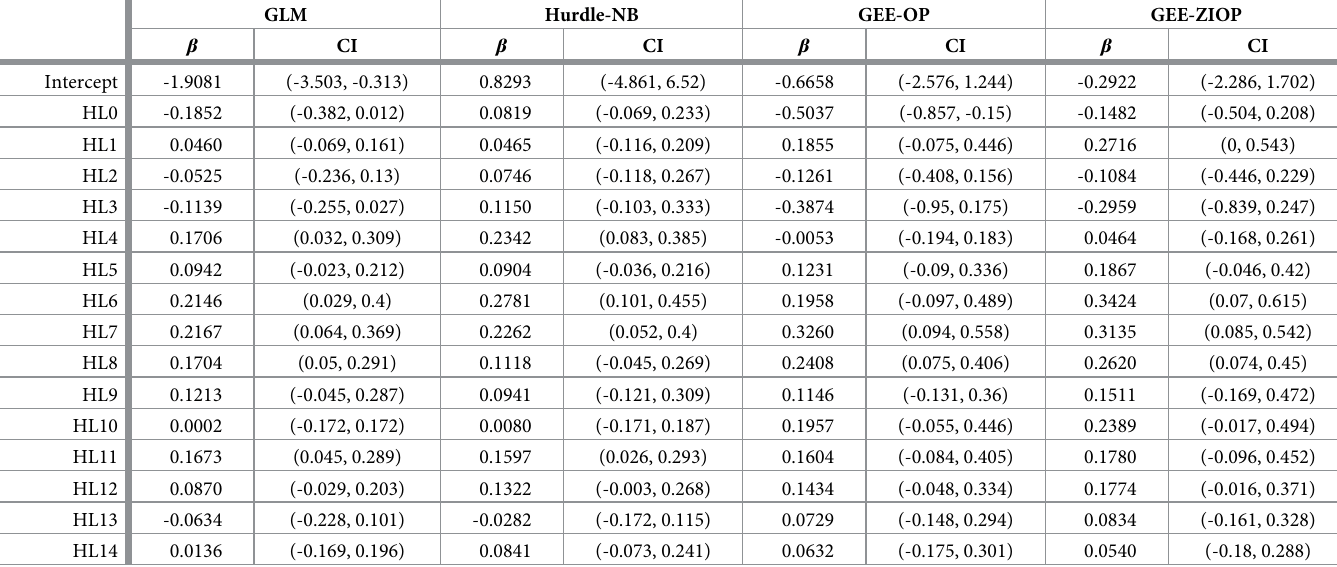
Table 2. Intercept and holiday coefficients with 95% confidence intervals based on robust standard errors.